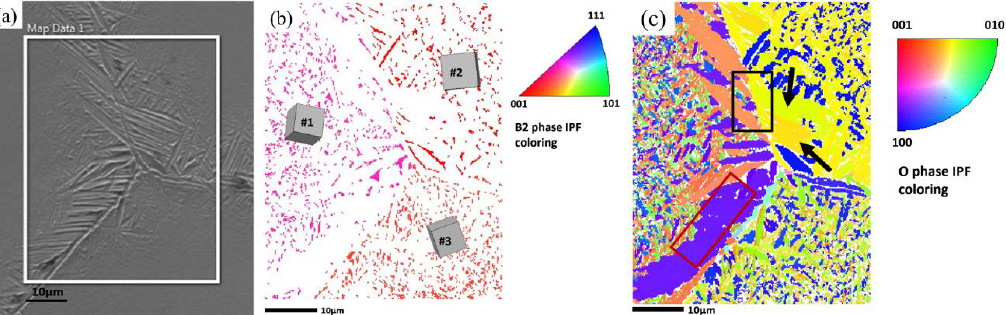
Figure 6. EBSD observations of Ti-22Al-25Nb alloy cooled at 0.1 °C/s from 1100 °C ( a ) scanning area, ( b ) IPF of B2 phase, ( c ) IPF of O phase.